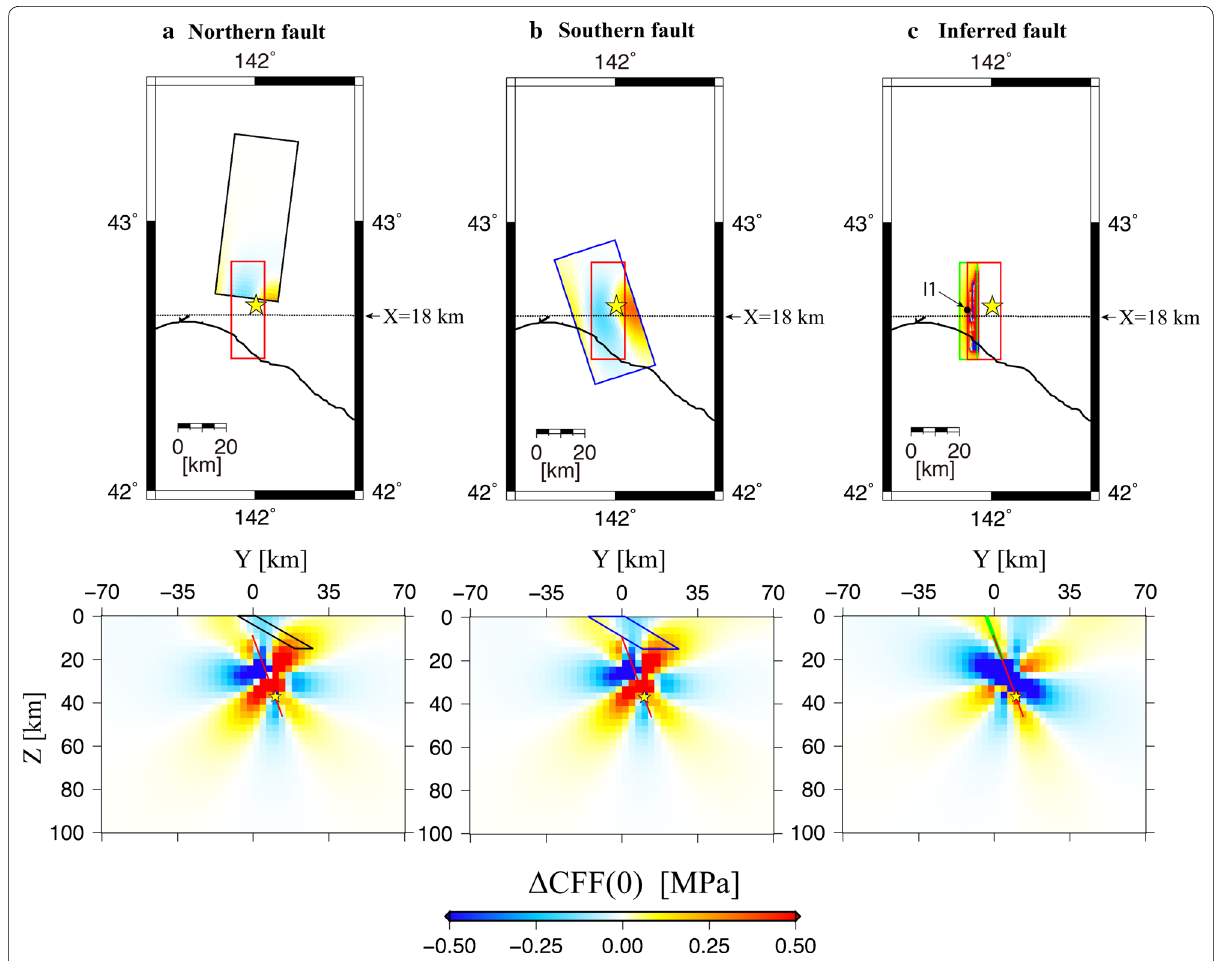
Fig. 5 Coseismic Coulomb stress (ΔCFF(0)) due to the Iburi earthquake for a the northern, b southern, and c SI faults. For each fault, the top panel shows the ΔCFF(0) resolved onto the target fault. The bottom panel shows the ΔCFF(0) on the receiver faults, which are distributed on the X 18 km plane (dotted line in the top panels), assumed to have identical source parameters as each target fault. The black, blue, and green = rectangles indicate the geometry of the northern, southern, and SI faults, respectively. In each panel, the red rectangle and yellow star show the fault model and hypocenter of the Iburi earthquake, respectively. The black circle in the top panel of c indicates observation point